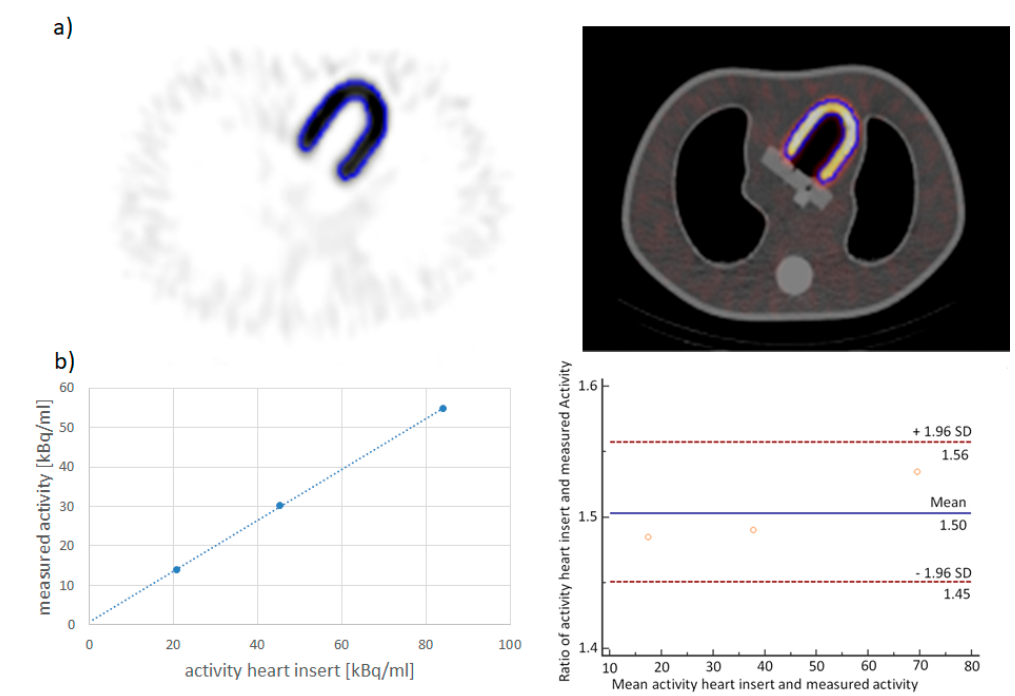
Figure 1. Phantom experiments: ( a ) The anthropomorphic thorax phantom with an activity of 20.8 kBq/mL in the heart insert and an activity of 2.0 kBq/mL in the background. A threshold of 39 percent of the maximum activity met the myocardial wall of the heart insert very well; ( b ) Relationship between the activity in the myocardial wall insert and the measured activity. The best fit straight line fits the data points very well (r = 0.9998, p = 0.01). Bland–Altman plot demonstrates a spread of the ratio between applied and measured activity arround a mean of 1.5.